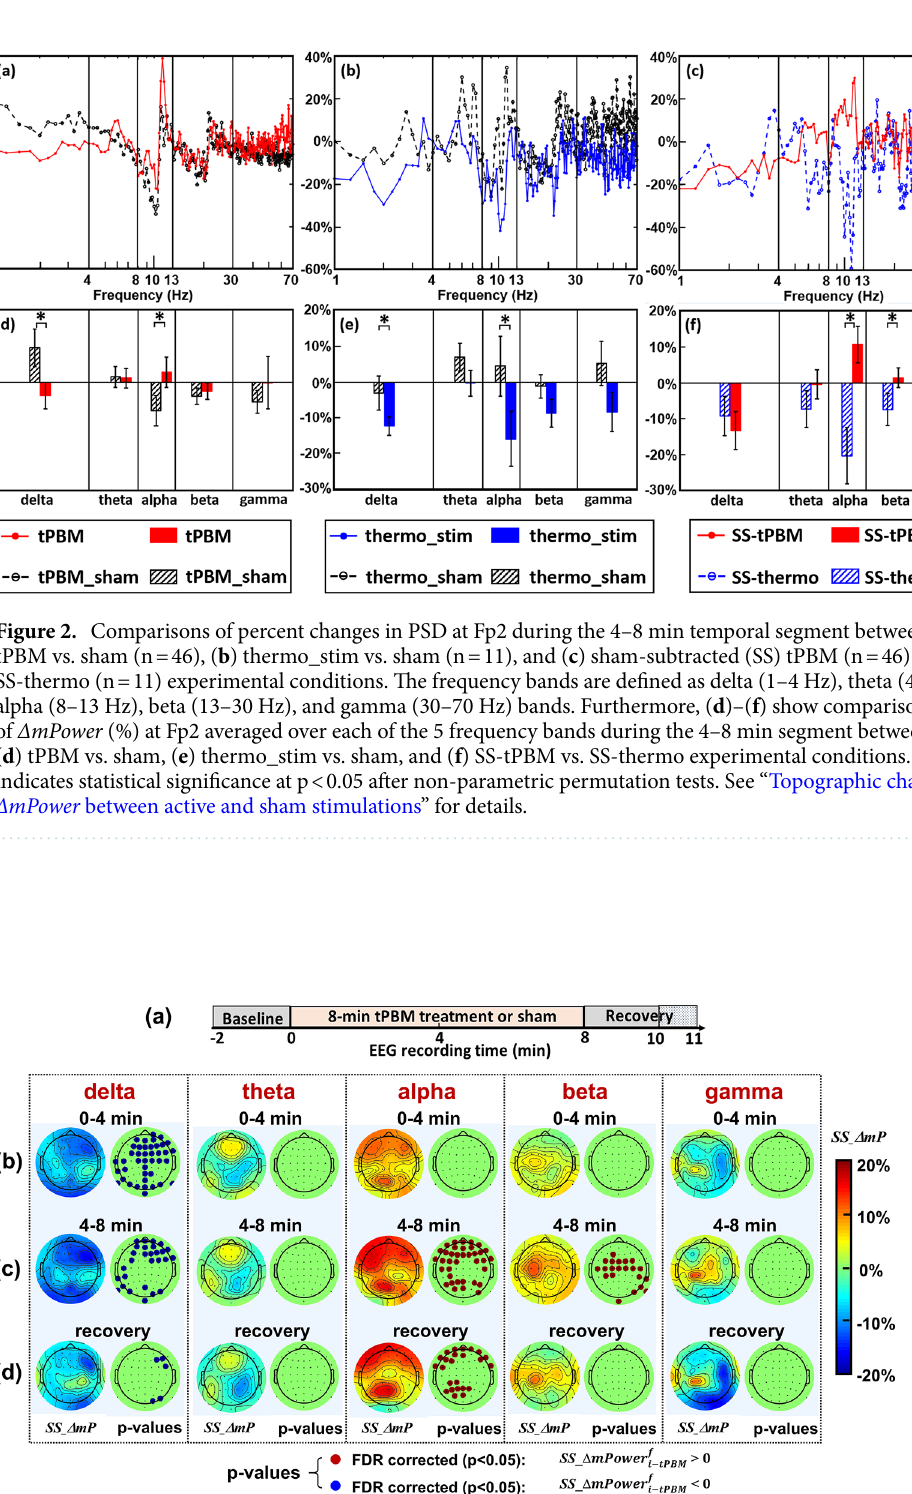
Figure 3. ( a ) Outlines the protocol timing: 2-min baseline, 0–4 min and 4–8 min temporal periods for tPBM/ sham, and 8–11 min recovery (only 8–10 min used for analysis). ( b )–( d ) show topographies of group-averaged (n = 46), sham-subtracted ΔmPower ( SS_ΔmP ) and FDR-corrected p-value maps based on paired permutation tests between SS_ΔmP values under tPBM vs sham conditions during 0–4 min tPBM/sham, 4–8 min tPBM/ sham, and 8–10 min recovery, respectively, at five frequency bands. In the p -value maps, the red dots correspond f > 0, marking the electrodes where tPBM created significant increases in ΔmPower to SS _ � mPower i − tPBM (FDR corrected p < 0.05) compared to the sham condition (see Eq. (4a)). In contrary, the blue dots with < 0 mark the electrodes where tPBM induced significant reduction in ΔmPower (FDR SS _ � mPower f i − tPBM corrected p < 0.05) compared to the sham